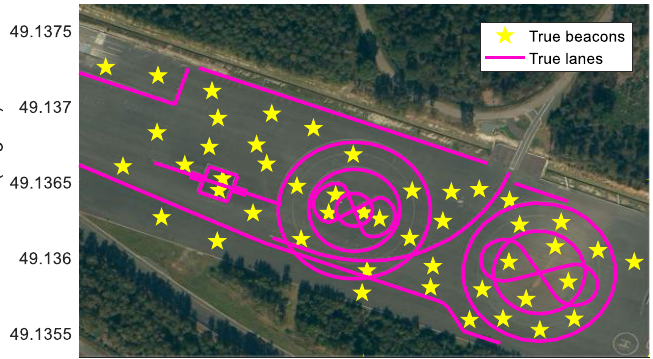
Figure 4. Test site for simulation: UTAC